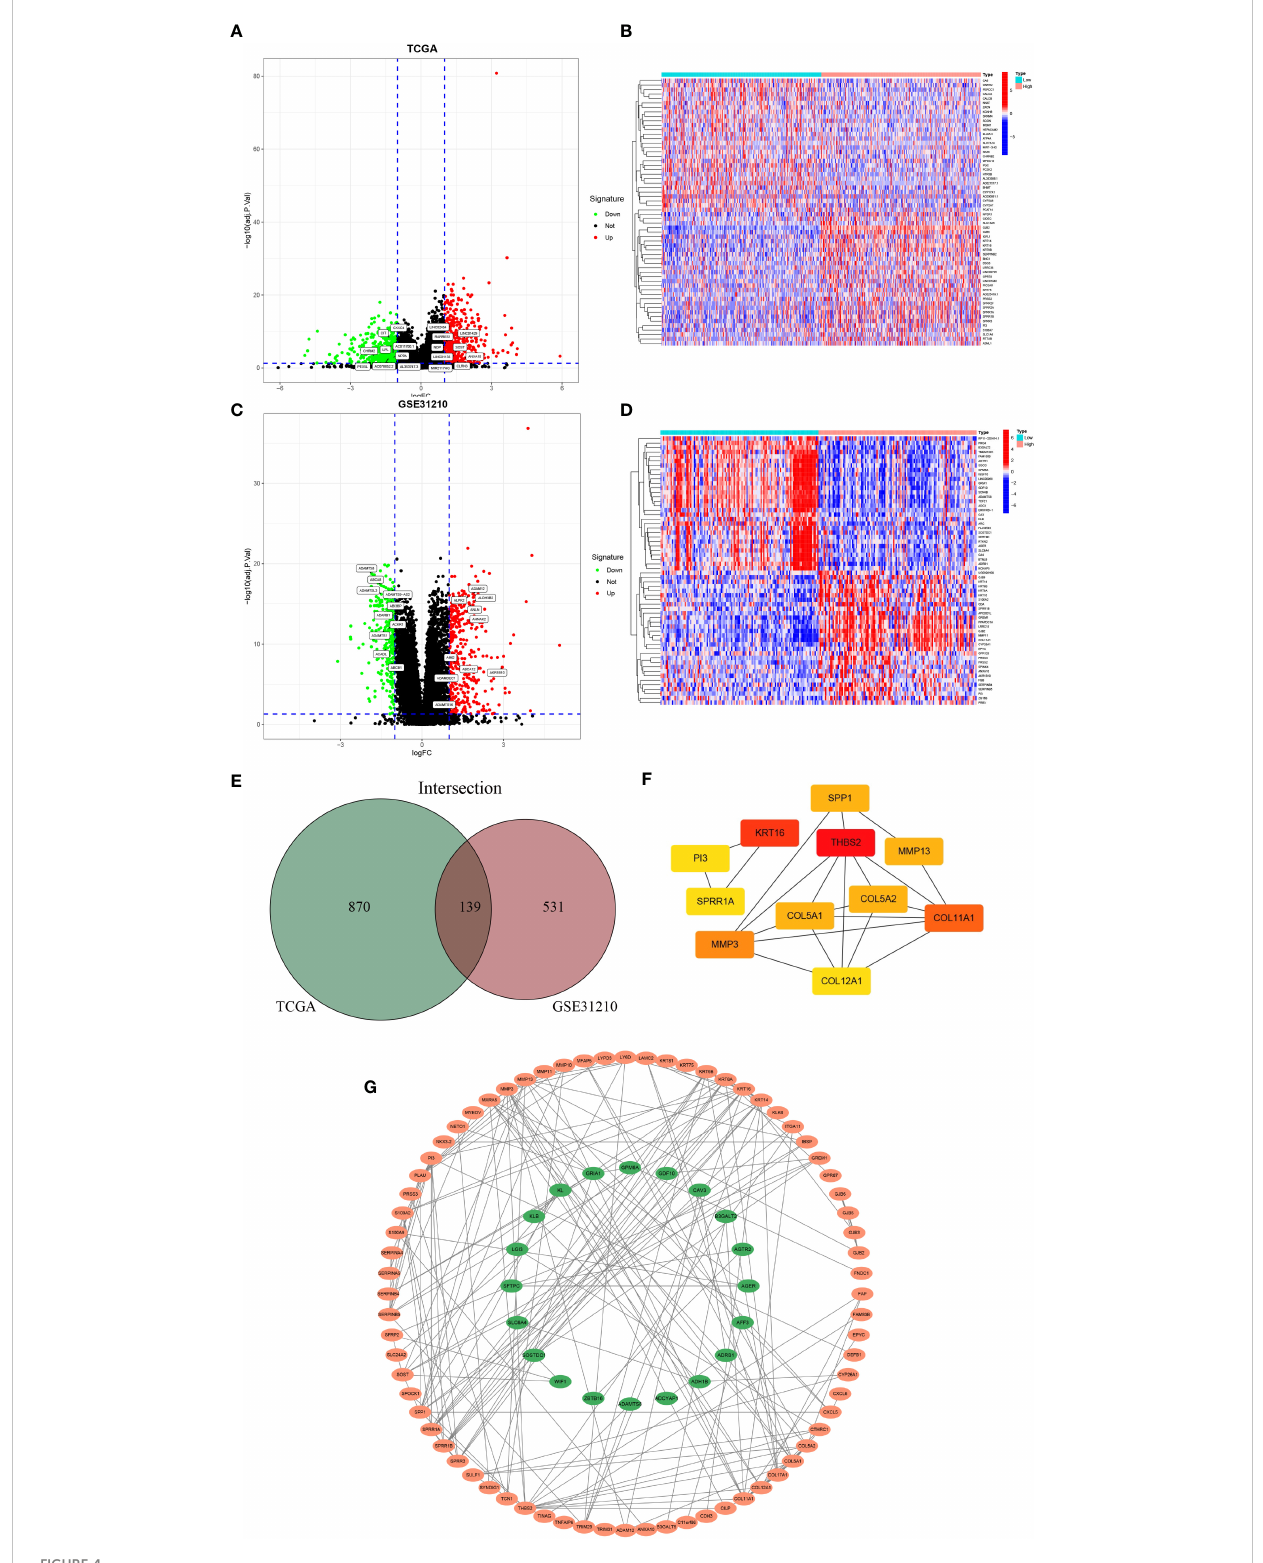
FIGURE 4 (A) Volcanic map of 1009 DEGs in TCGA and related representative genes. Red: up-regulation; green: downregulation; black: normally expressed mRNAs. (B) Heatmap of representative top 60 genes based on high and low GJB2 expression group in TCGA. (C) Volcanic map of 670 DEGs in GSE31210 dataset and related representative genes. (D) Heatmap of representative top 60 genes based on high and low GJB2 expression group in GSE31210 dataset. (E) Venn diagram shows the intersecting DEGs from GEO and TCGA. (F) Top 11 genes with high node degree in cytoscape. (G) Visualized PPI analysis of DEGs based on